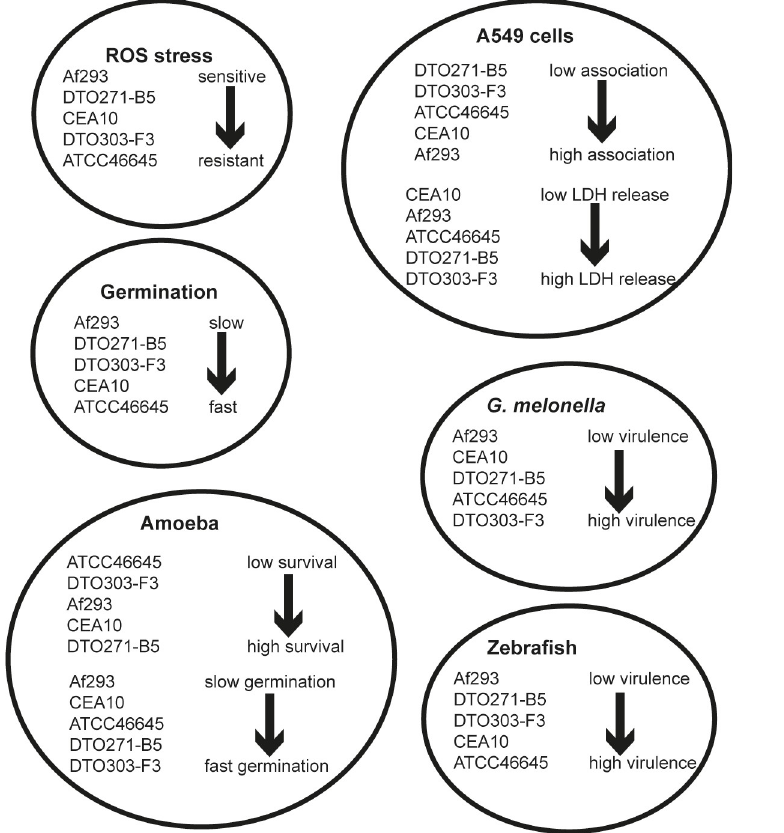
Fig 13. Summary of the main findings. A complete overview can be found in S5